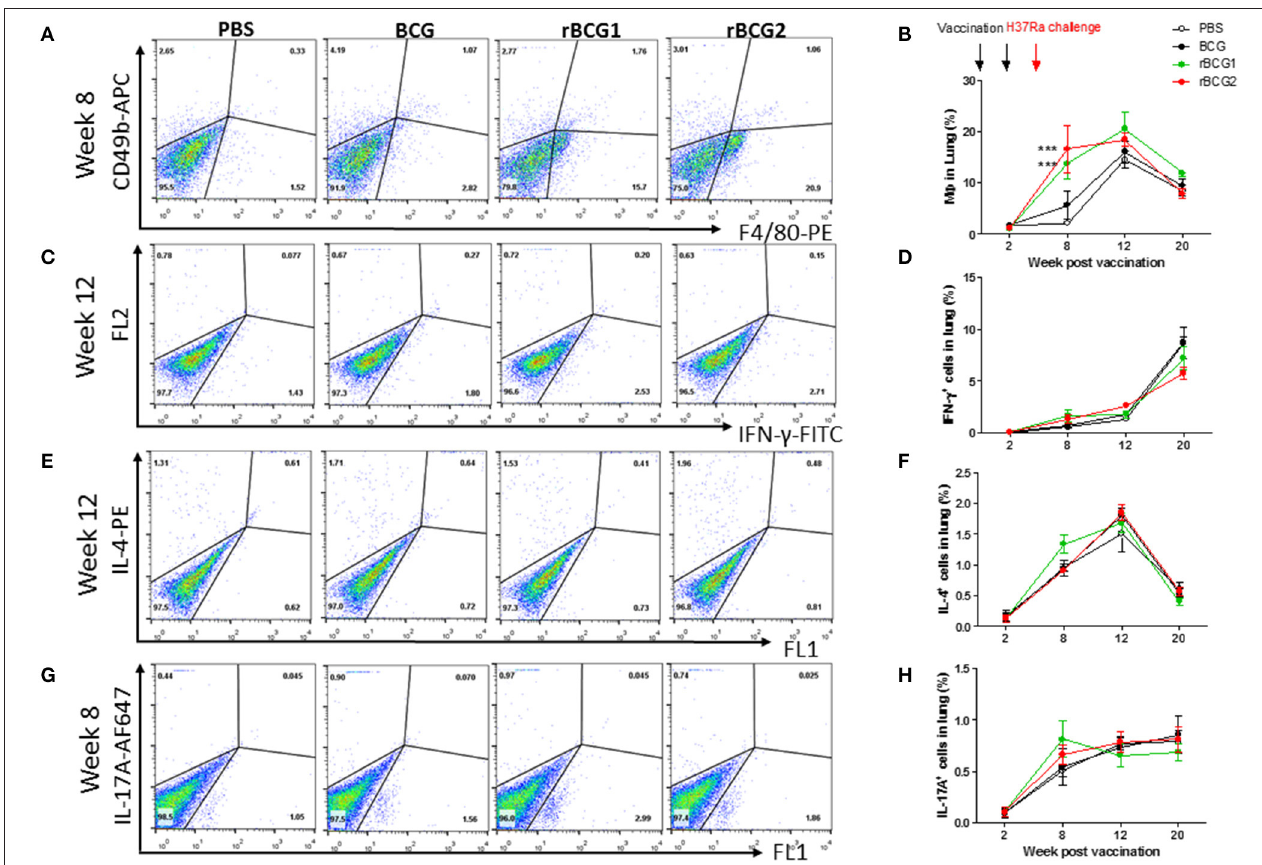
FIGURE 4 | Innate and adaptive immune cell profiles pulsed with tuberculosis-specific peptides from mice immunized with BCG, rBCG1, or rBCG2. C57BL/6 mice were immunized with BCG, rBCG1 or rBCG2 at weeks 0 and 2, and then challenged with H37Ra at week 4 ( n = 6–7, in two independent experiments). At 2, 8, 12, and 20 weeks, the mice were sacrificed, and lungs were homogenized to single-cell suspensions. The cells were stimulated with tuberculosis-specific TB peptides (described in the Materials and Methods) for 68h and then Golgi-stop for 4h, stained for surface and intracellular markers, and then subjected to flow cytometry to determine the percentage of cytokine-producing cells within CD4 + T cells. (A) Percentage of macrophages (F4/80 + cells) in lung post-vaccination at week 8. (B) Percentage of macrophages (F4/80 + cells) in lung post-vaccination at weeks 2–20. (C) Percentage of IFN- γ + cells in lung post-vaccination at week 12. (D) Percentage of IFN- γ + cells in lung post-vaccination at weeks 2–20. (E) Percentage of IL-4 + cells in lung post-vaccination at week 12. (F) Percentage of IL-4 + cells in lung post-vaccination at weeks 2–20. (G) Percentage of IL-17 + T cells in lung post-vaccination at week 8. (H) Percentage of IL-17 + T cells in lung post-vaccination at weeks 2–20. Differences among groups were determined by one-way or two-way ANOVA with a Tukey or Bonferroni post hoc test (*** P <